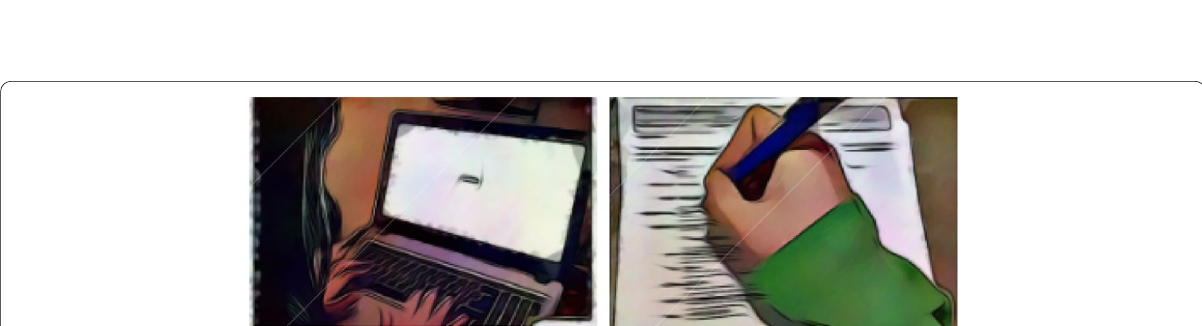
Fig. 2 The classical LDT. The left‑hand page is the paper adaptation for the LDT where participants crossed the words from